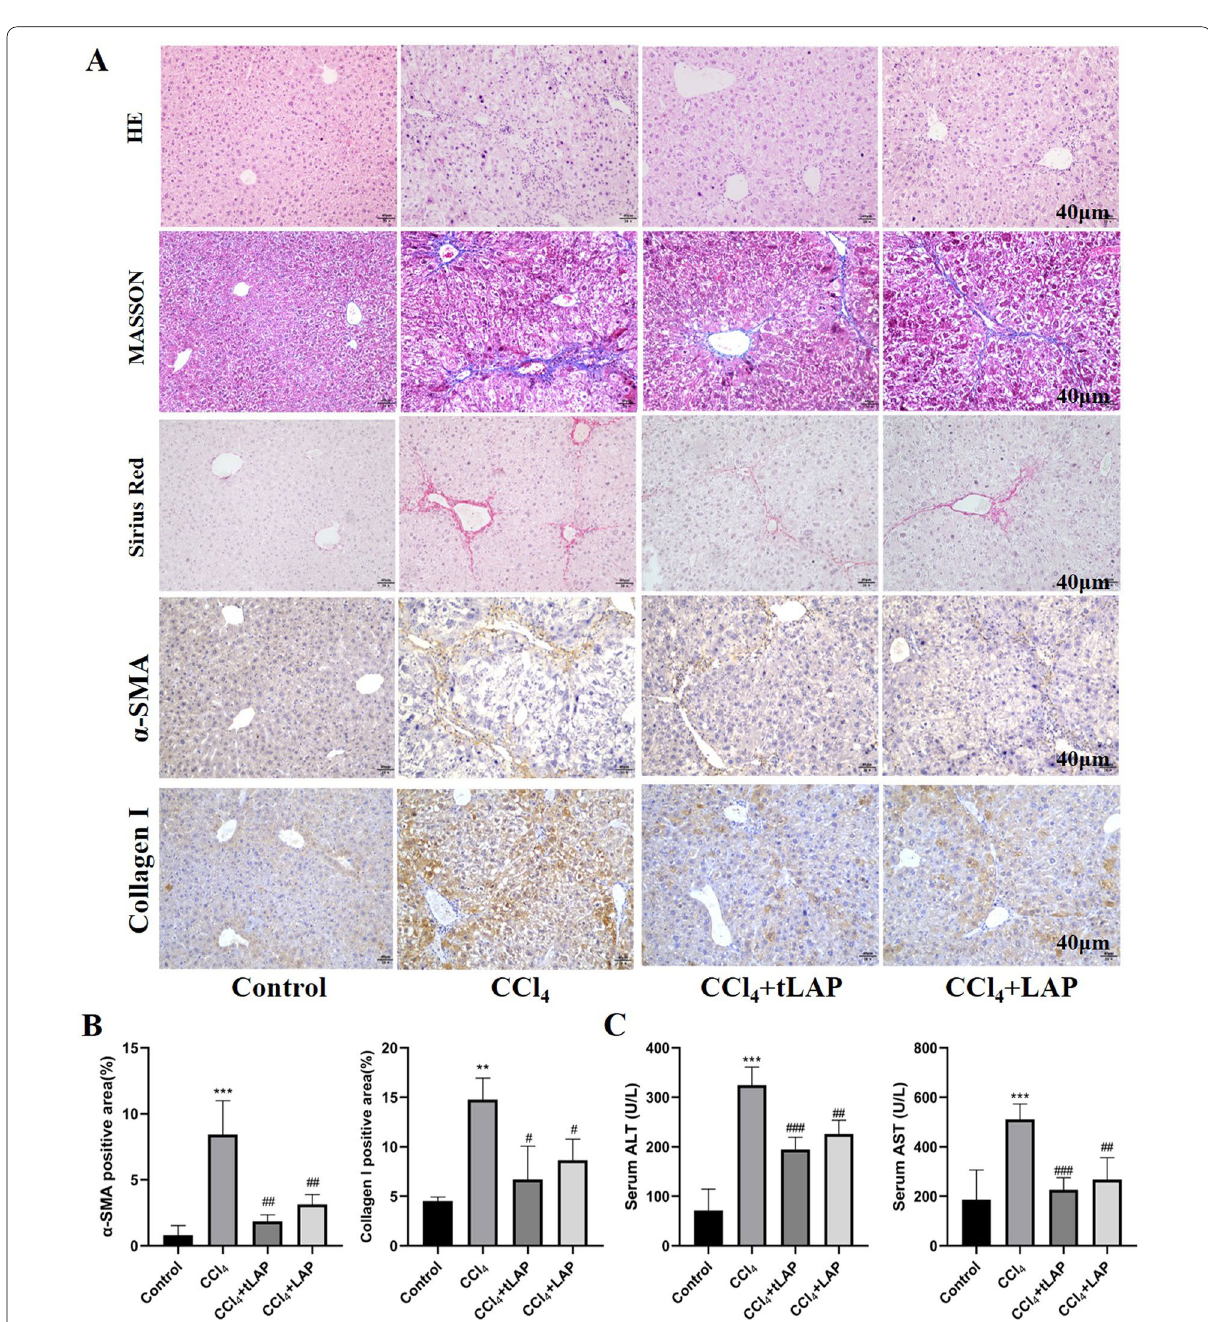
and immunohistochemistry of the liver tissues. B Detection of serum ALT and AST activity in C57BL/6 mice. ***P < 0.001 vs control group; # P < 0.05